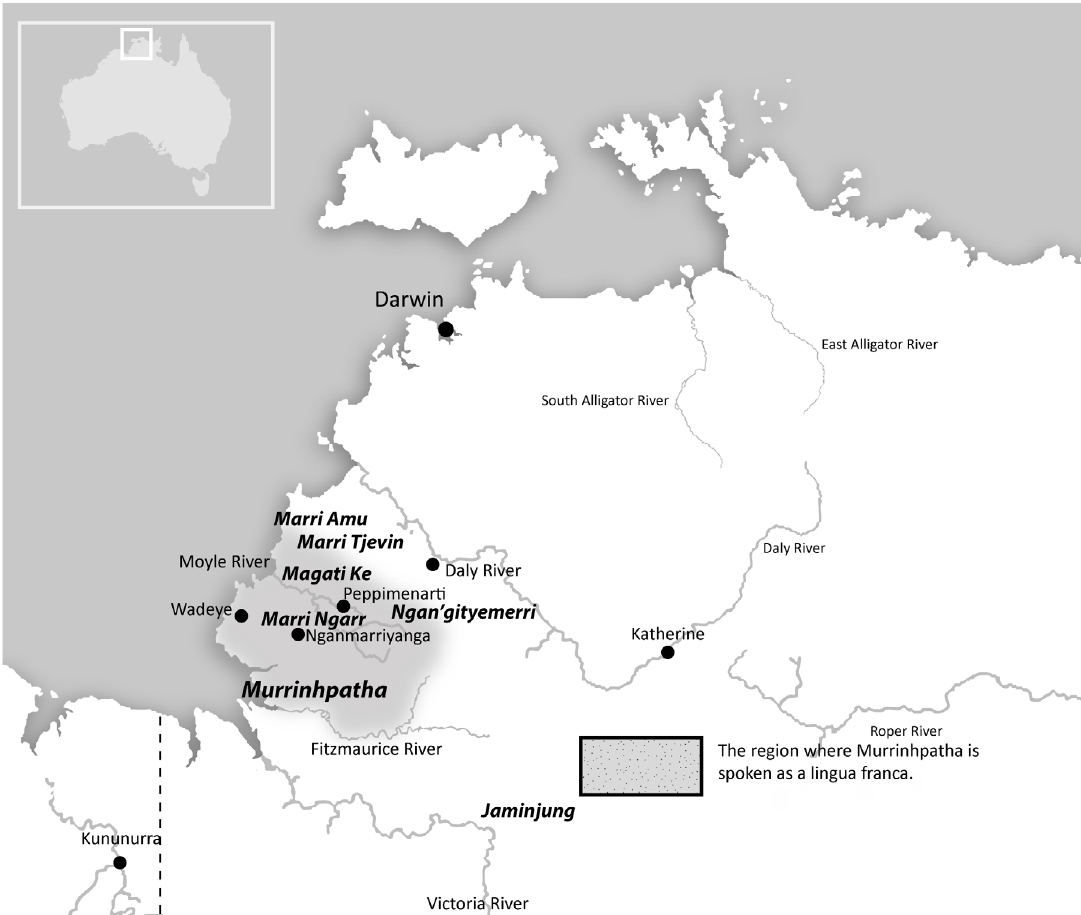
Figure 1: The Fitzmaurice and Moyle Rivers region of Australia‘s Northern